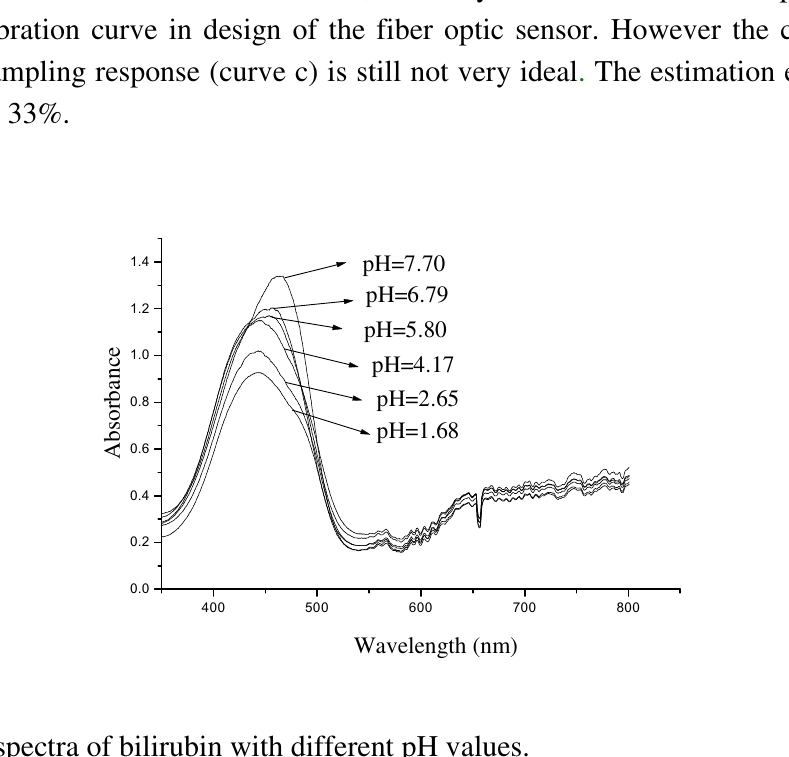
Figure 6. Absorbance spectra of bilirubin with different pH values.